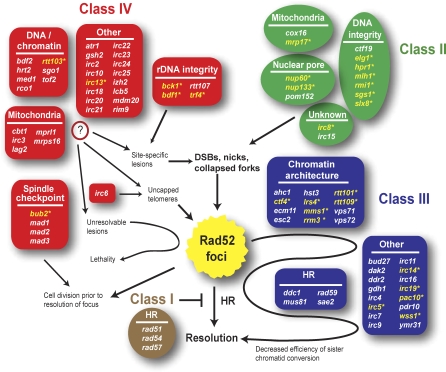
Pathways Leading to Increased Rad52 Foci Are Revealed by This StudyClass I mutants block HR subsequent to the formation of Rad52 foci. Class II mutants stimulate the formation of DNA lesions, which is reflected as increased focus formation and results in increased sister chromatid and interhomolog recombination. Class III mutants decrease the efficiency of sister chromatid recombination through effects on cohesion, chromatin architecture, HR, and other mechanisms, thereby increasing the duration of Rad52 foci (indicated by the meandering line). Class IV mutants do not have a global effect on homologous recombination. However, the focus phenotype in some mutants reflects recombination at specific sites such as rDNA or telomeres. Other mutants may cause the division of cells prior to resolution of HR foci, or lead to the generation of lesions that cannot be repaired, resulting in lethality. For all classes, mutations with an asterisk and highlighted in yellow, sensitize cells to the absence of Rad52 (see Table 2).